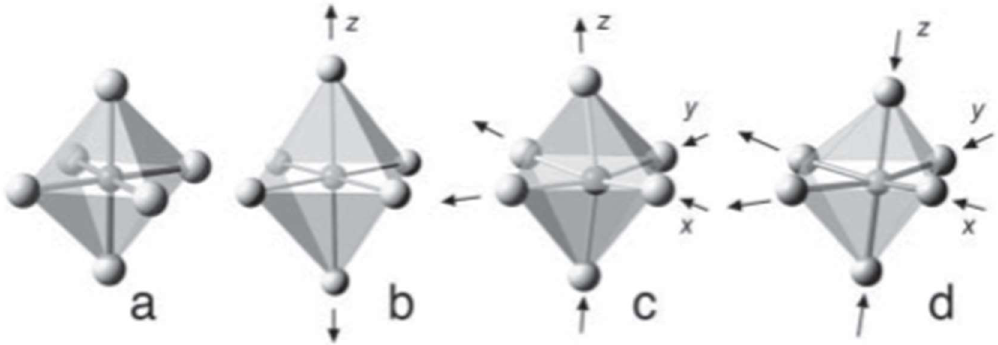
Figure 5. Different types of octahedral packing ( a ) no distortion (cubic TiO), ( b ) tetragonal distortion(rutile) ( c ) trigonal distortion (Ti 2 O 3 ) ( d ) orthorhombic- like distortion (Ti 4 O 7 and Ti 5 O) Reproduced from [90], Copyright 2007, American Mineralogist.